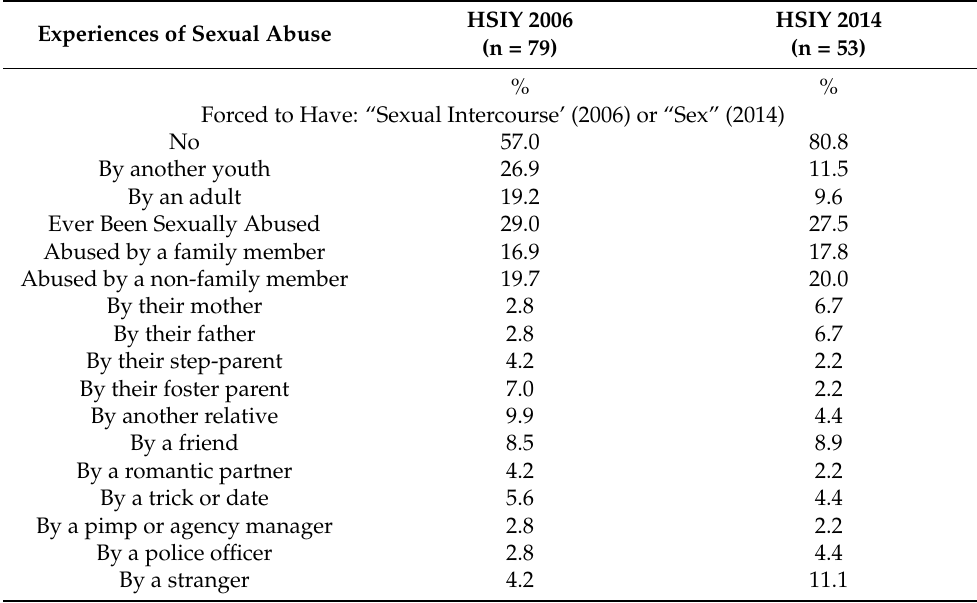
Table 5. Sexual abuse reported by sexually exploited